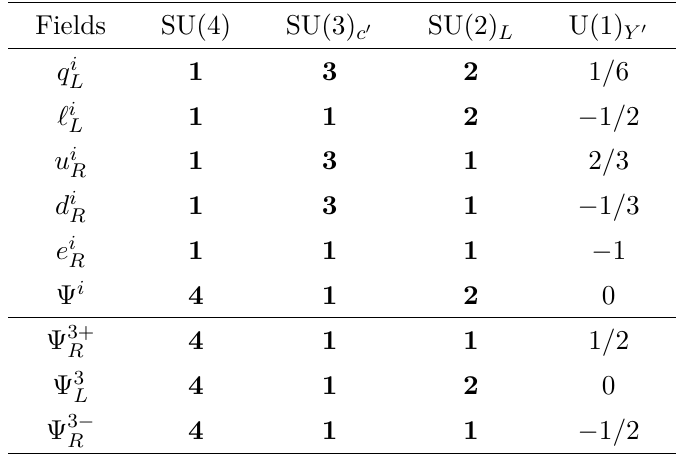
Table 3 . Matter sector of the standard 4321 model (first block with i = 1 , 2 , 3 ) or the flavoured 4321 model (first and second blocks with i = 1 , 2